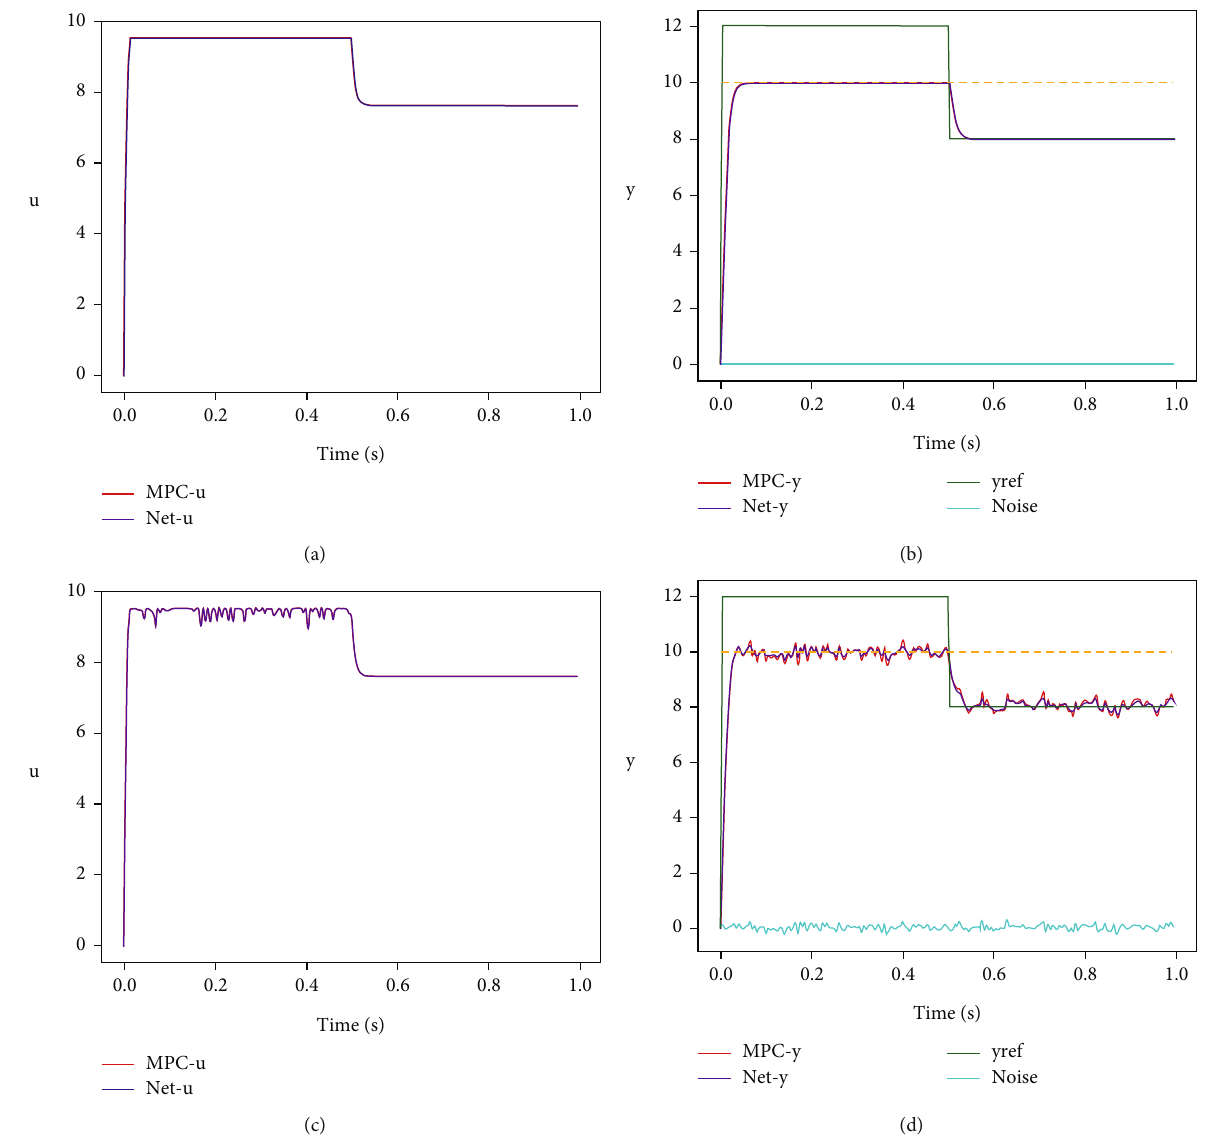
Figure 11: Constrained control process. (a, b) The trajectories of control u and output y when the reference y boundary without noise, while (c, d) are the corresponding trajectories under the noise ξ . Table 2: Average tracking error and run time results of proposed DL-MPC and